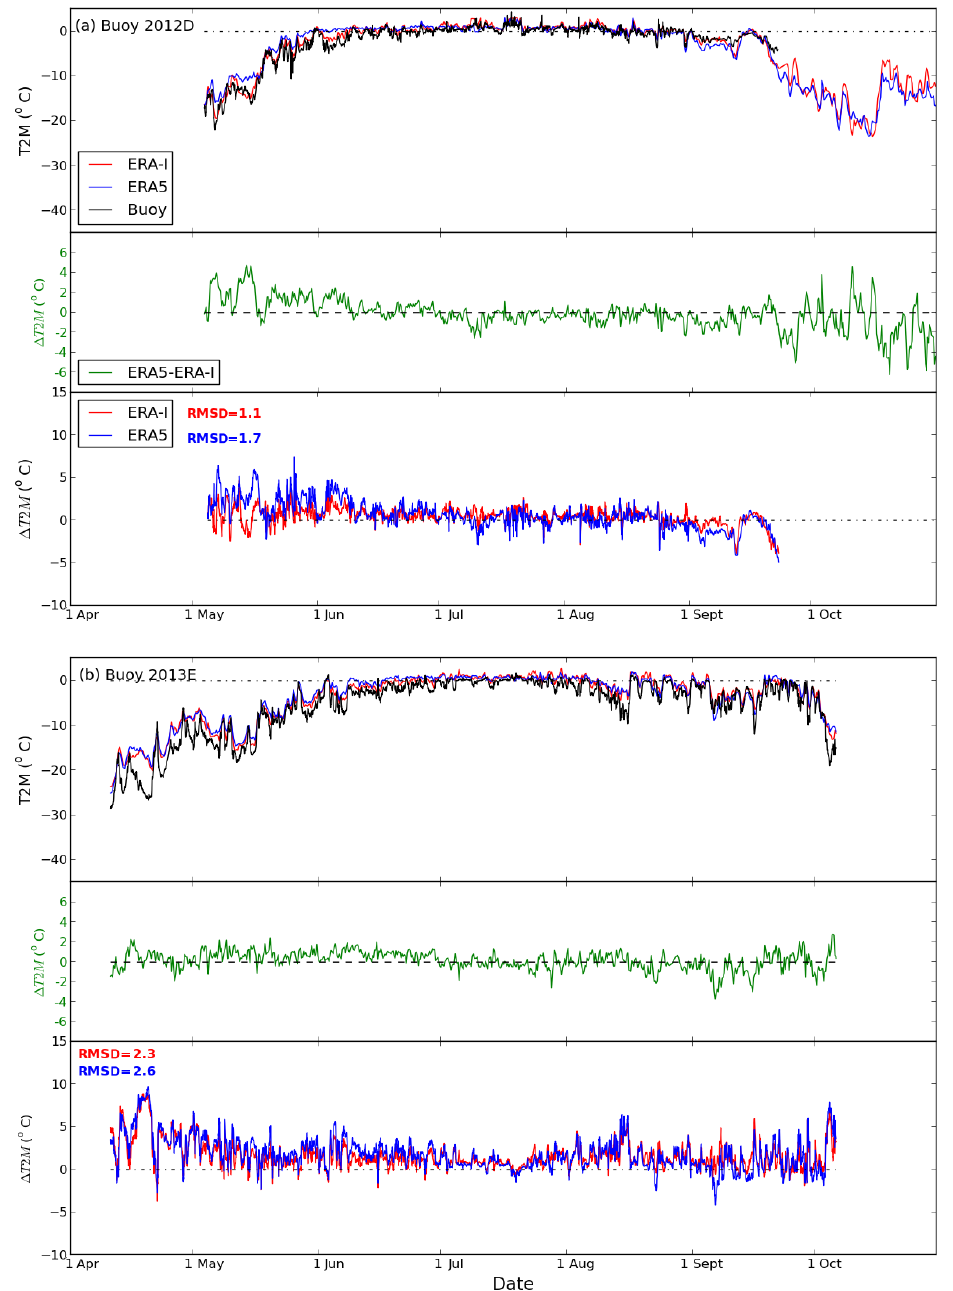
Figure 3. Variation in 2m air temperature (T2M) in ERA5, ERA-I, and the buoys (upper panel) and the differences of T2M between ERA5 and ERA-I (mid-panel; green) and comparisons for ERA5 and ERA-I with buoys (ERA5 minus buoy; ERA-I minus buoy) for buoys (a) 2012D and (b) 2013E. RMSD values for the comparison between ERA products and buoys are shown as text, blue for ERA5-buoy, red for